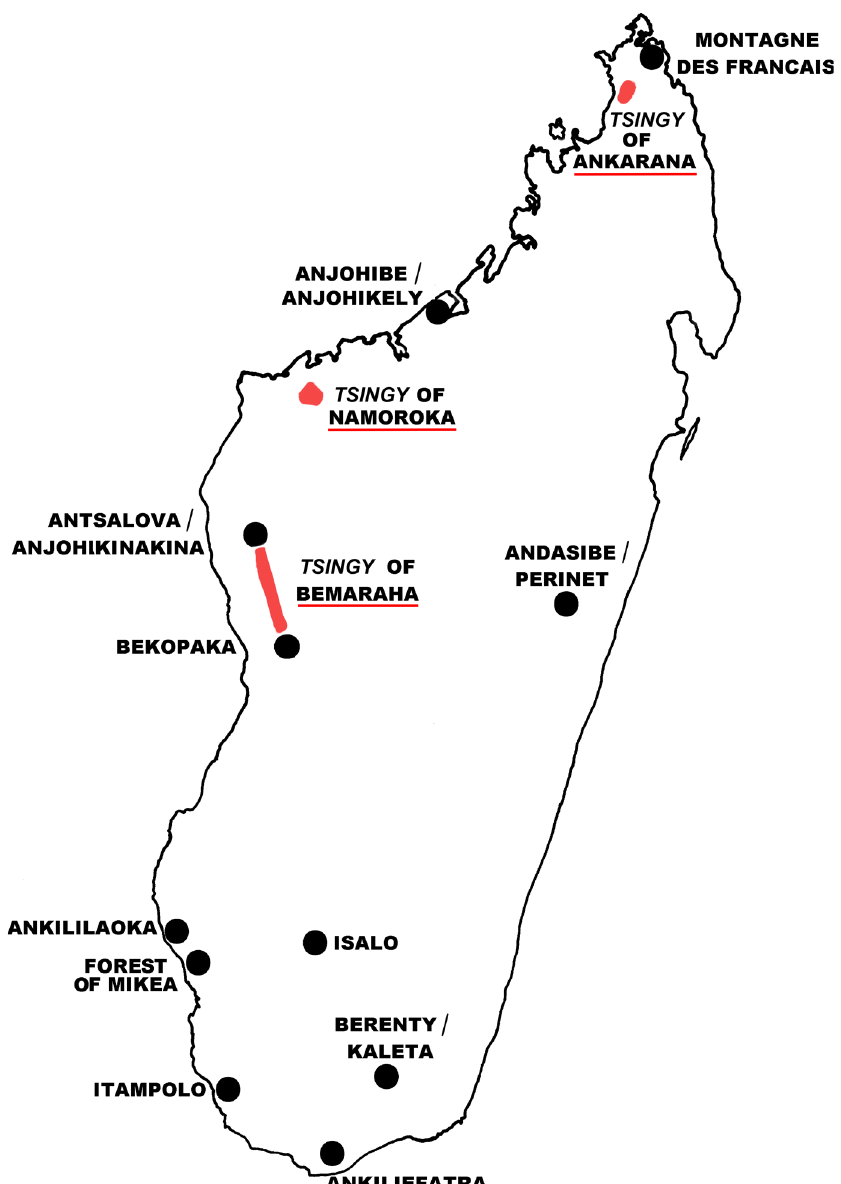
Figure 1. Map of Madagascar showing the tsingy of Ankarana, the other tsingy , and the places where sand fl ies were